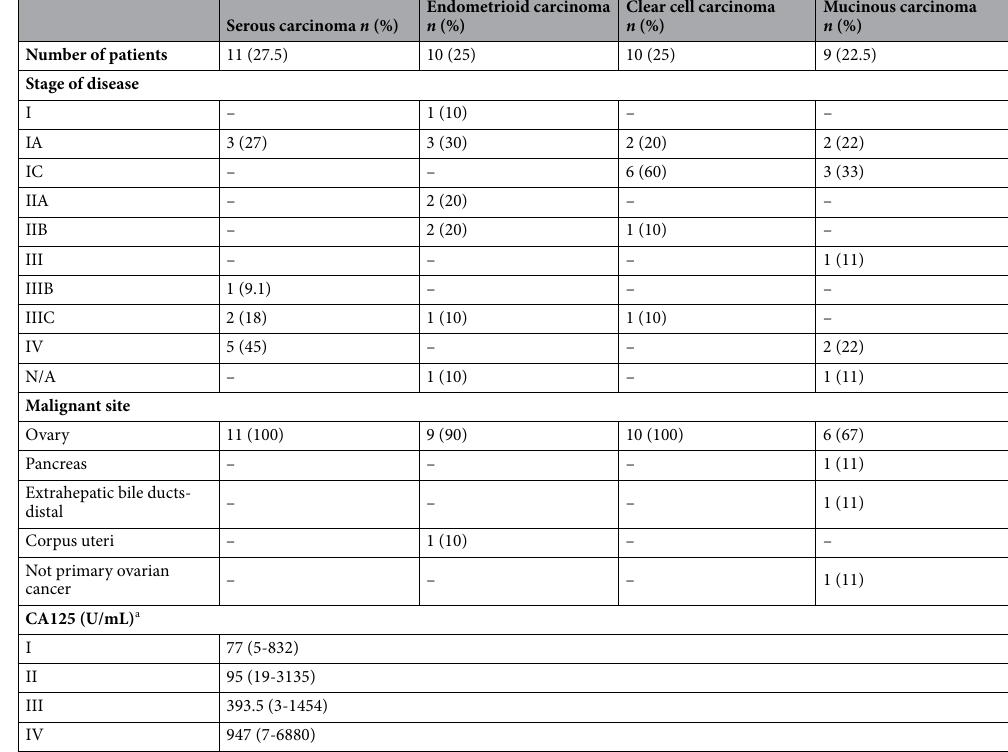
Table 1. Clinicopathological data of the patients included in the study. N/A – data not available. a Data expressed as median and range for a given stage of the